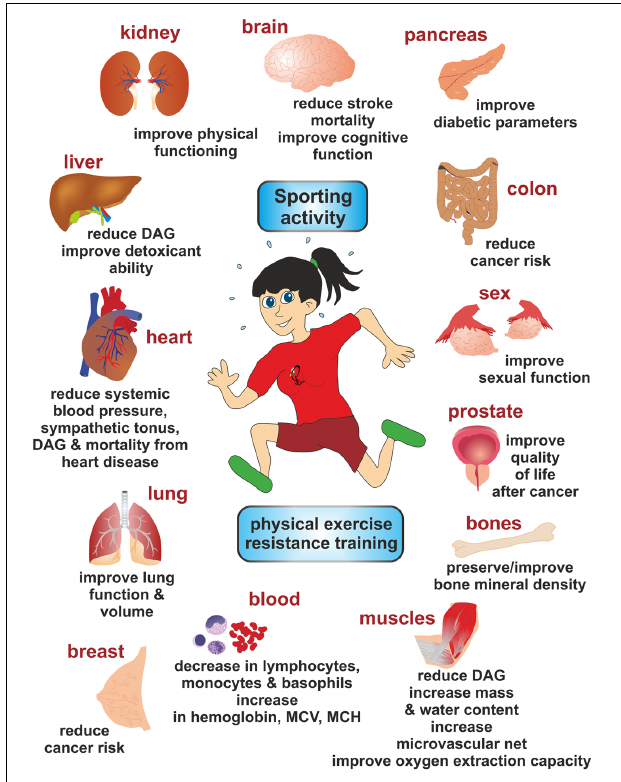
FIGURE 1 | Representative health-promoting effects of sports, physical exercise, and resistance training on various organs. Numerous reports have shown that sporting activity promotes health and functionality of muscles, lung, heart, liver, kidney, brain, pancreas, colon, prostate, and bones. In addition, it is reported that doing sports improves sexual function and significantly impacts the composition of the blood. Abbreviations used are: DAG, diacylglyerol; MCH, mean corpuscular hemoglobin; MCV, mean corpuscular